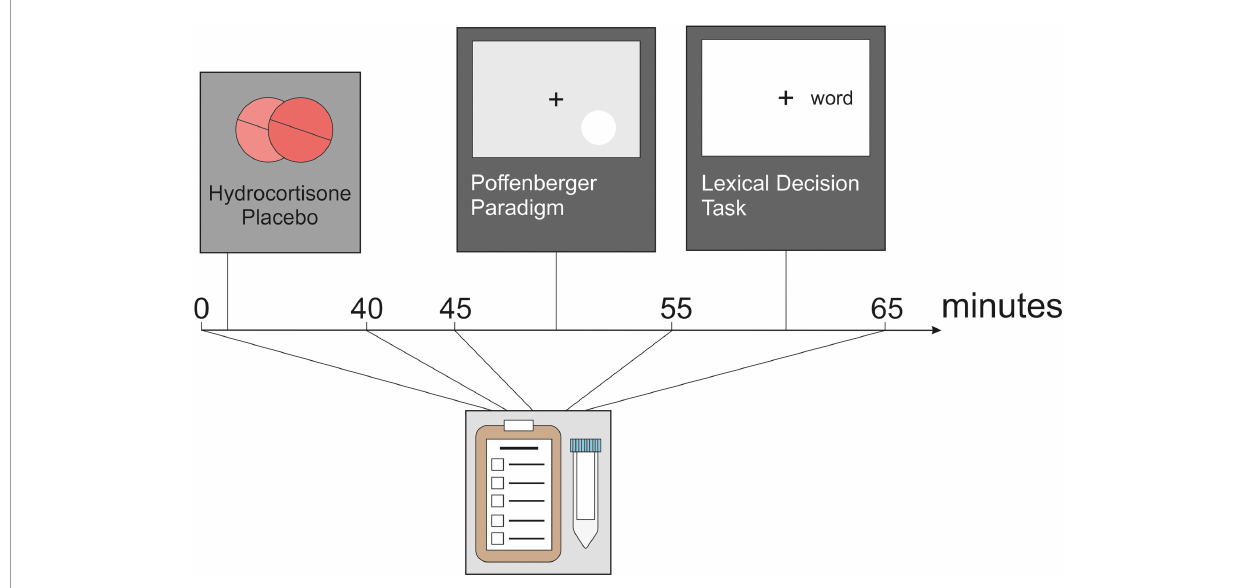
FIGURE1 Experimental design. After administration of hydrocortisone or placebo, the participants completed a 5 min resting-state EEG as well as a Poffenberger paradigm and a lexical decision task. Before hydrocortisone administration and after each section of the experiment, cortisol, and affect are